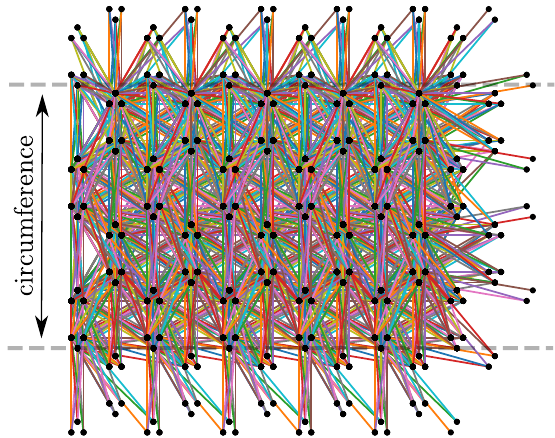
FIG. 17. Connectivity graph for van der Waals interactions on the ruby lattice. Black dots denote the ruby lattice with ρ ¼ 3 [also see Fig. 9(c)]. Each line represents a coupling in V ð r Þ ¼ Ω ð R =r Þ 6 that is included in the numerics for the phase diagram b in Fig. 10. The gray dashed lines denote how this coupling is wrapped into an XC-8 cylinder; any site of the ruby lattice outside this region can be identified with a site inside this region. The cylinder is infinitely long in the horizontal